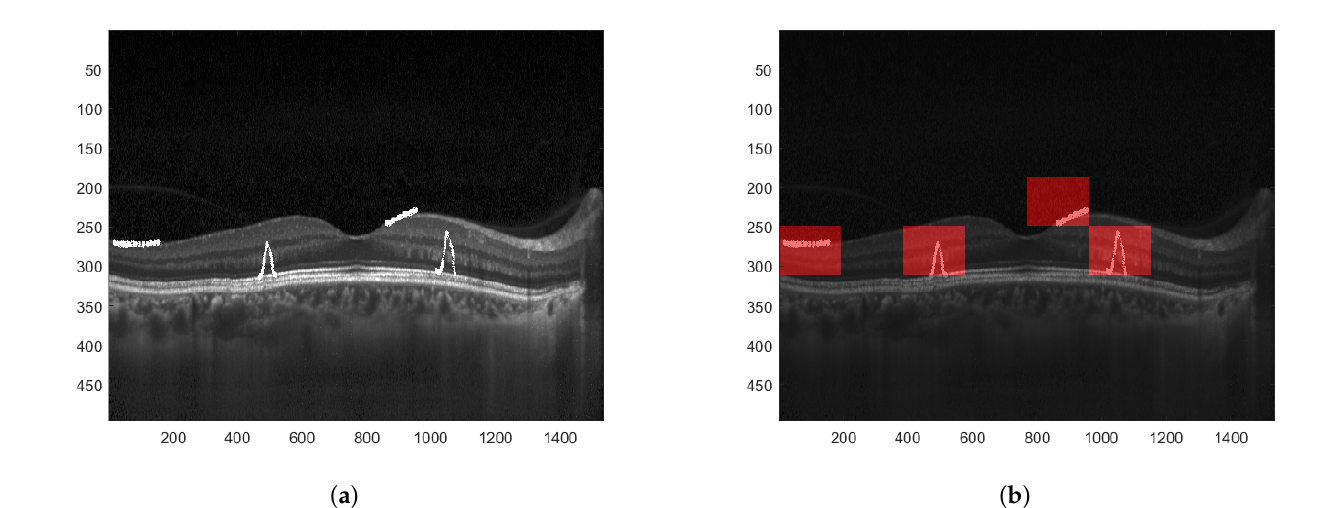
Figure 9. Result of image manipulation detection with greater precision. ( a ) Tampered watermarked image. ( b ) Detected regions with greater